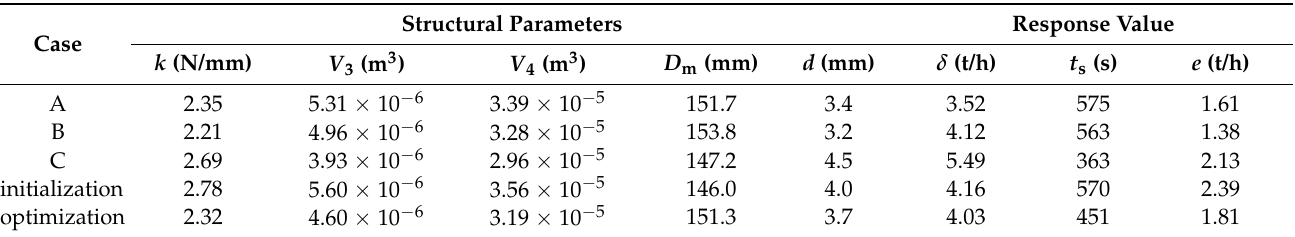
Table 3. NSGA-II solution results.